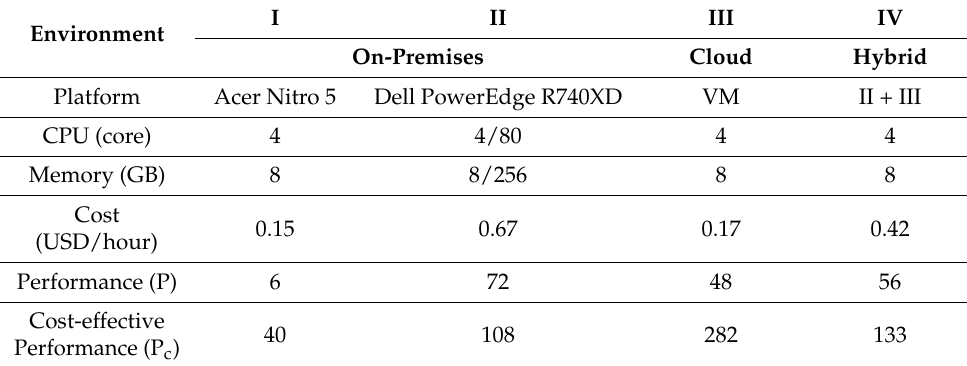
Table 2. Configurations, costs, and performance of node types used in simulation